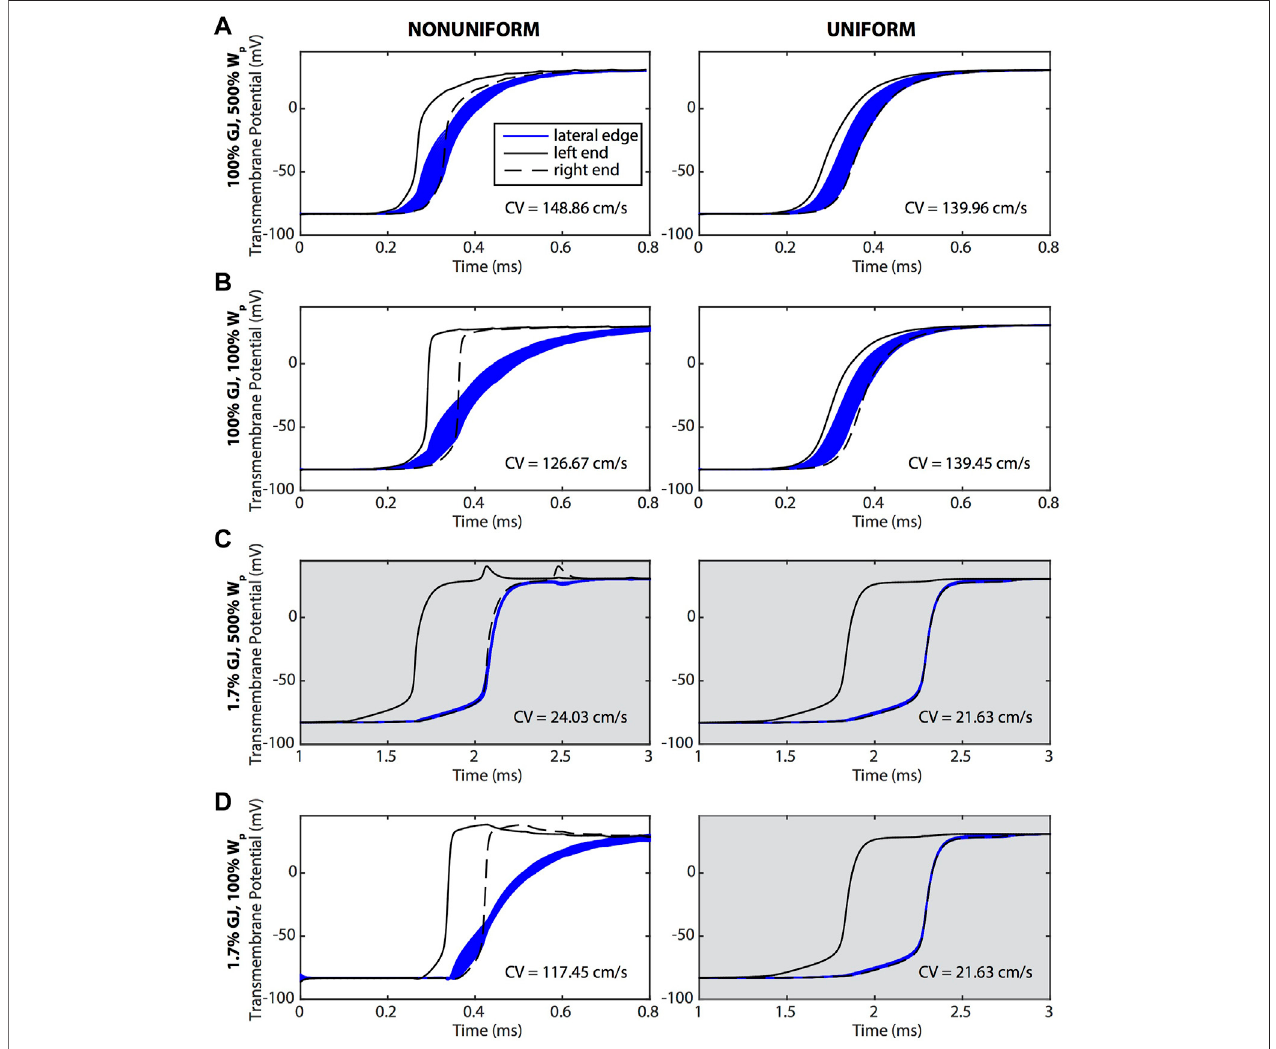
FIGURE 2 | Transmembrane potentials along the ends (black) and lateral edges (blue) of a cell undergoing an AP that is traveling from left to right. The left column (nonuniform) shows cells with sodium and potassium ion channels preferentially distributed on the ends of the cells, and the right column (uniform) shows cells in which ion channels were evenly distributed over the surface of the cell. (A) The widest W P case was compared against tissue where (B) W p was nominal, (C) GJ coupling was reduced and W p was wide, and (D) W p was nominal and GJ coupling reduced. In general, APs traveling along the length of the cell were responding to the depolarization at the ends of the cell. The CVs for each case are reported on the graphs. Gray shading indicates panels having a longer time scale due to slower conduction